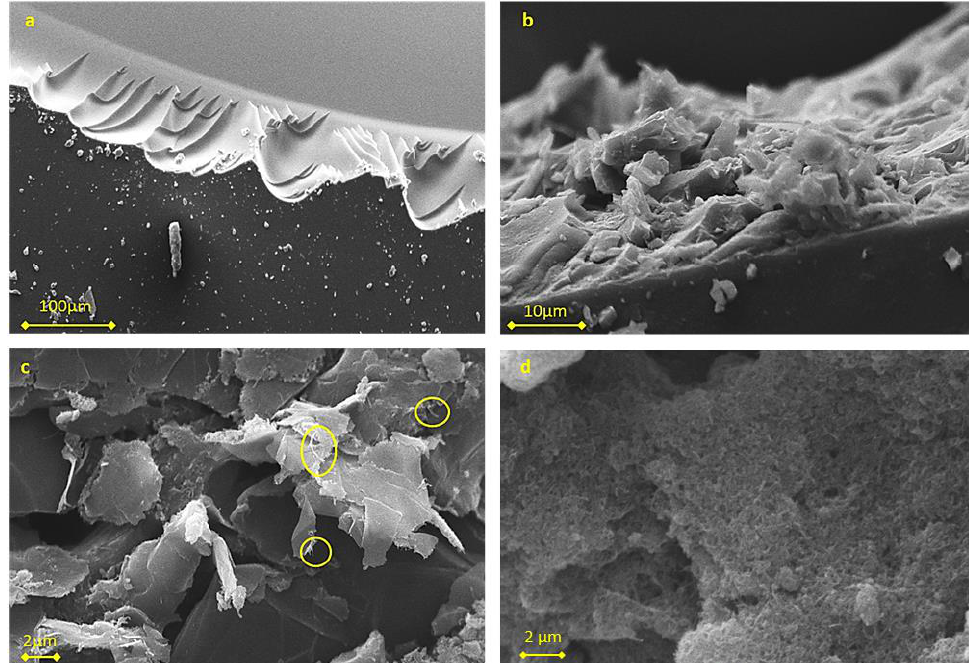
Figure 1. SEM images from the internal space of ( a ) Neat PEGDA polymer and PEGDA reinforced with ( b ) Graphene ( c ) Hybrid and ( d ) MWNTs. In image ( c ) some MWNTs that are visible in the surface have been marked.